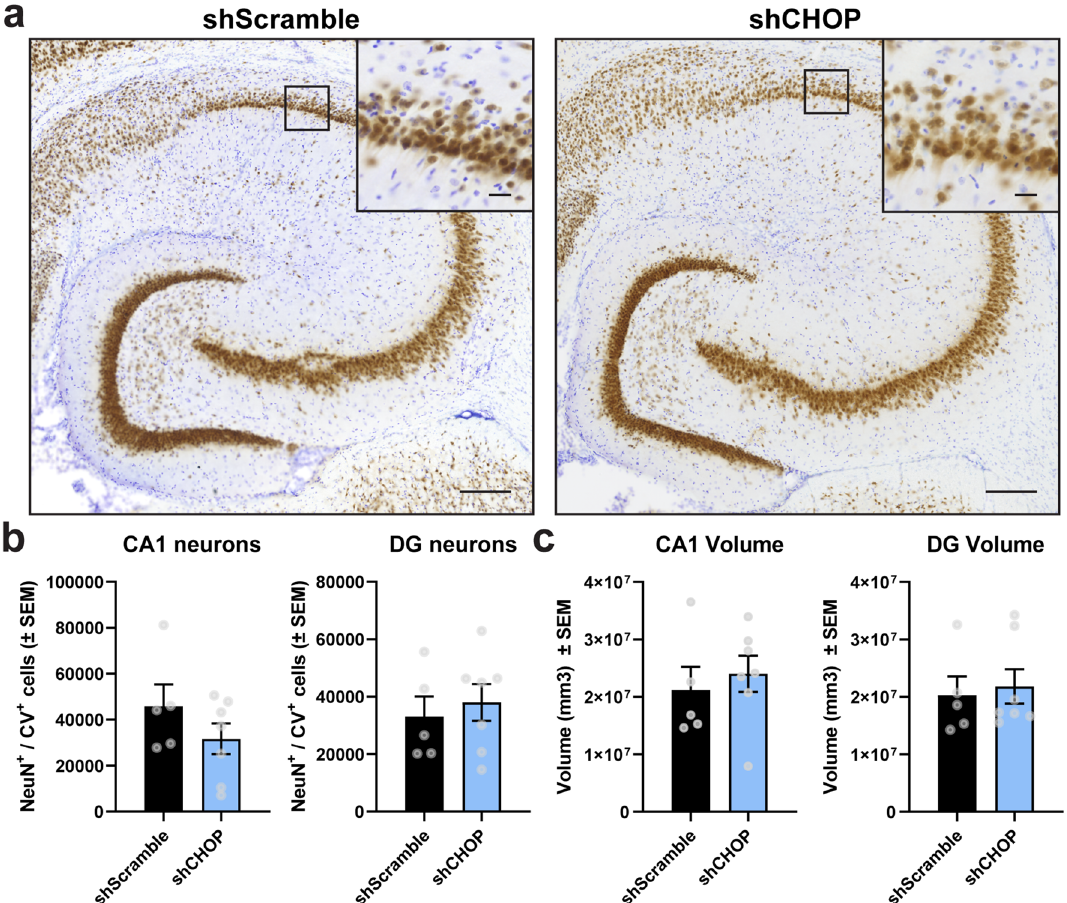
Figure 4. Changes in CHOP levels do not cause neuronal death in the hippocampus of aged rTg4510 mice. ( a ) Representative images from hippocampal neurons co-stained with NeuN (brown) and cresyl violet (purple) obtained from animals transduced with shScramble [n = 5] or shCHOP [n = 7] AAV9. ( b ) Neuronal density and ( c ) volume in the CA1 and DG areas were assessed using unbiased stereology. Results represent the standard error of the mean (± SEM). Data was analyzed by a Student’s t-test. Scale bars = 200 μm and inset scale represents 20 µm. CV cresyl violet, CA1 Cornu ammonis subfield 1, DG dentate